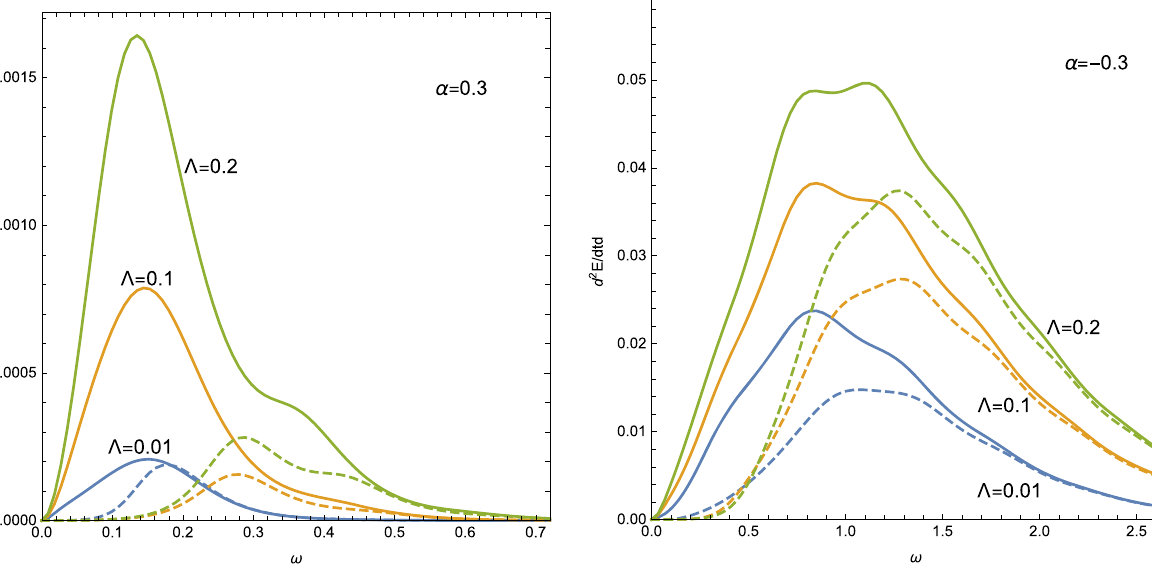
Fig. 7 Effect of (cid:3) on the power spectra of Hawking radiation. Solid lines for ξ = 0 . 1, dashed lines for ξ = 0 .